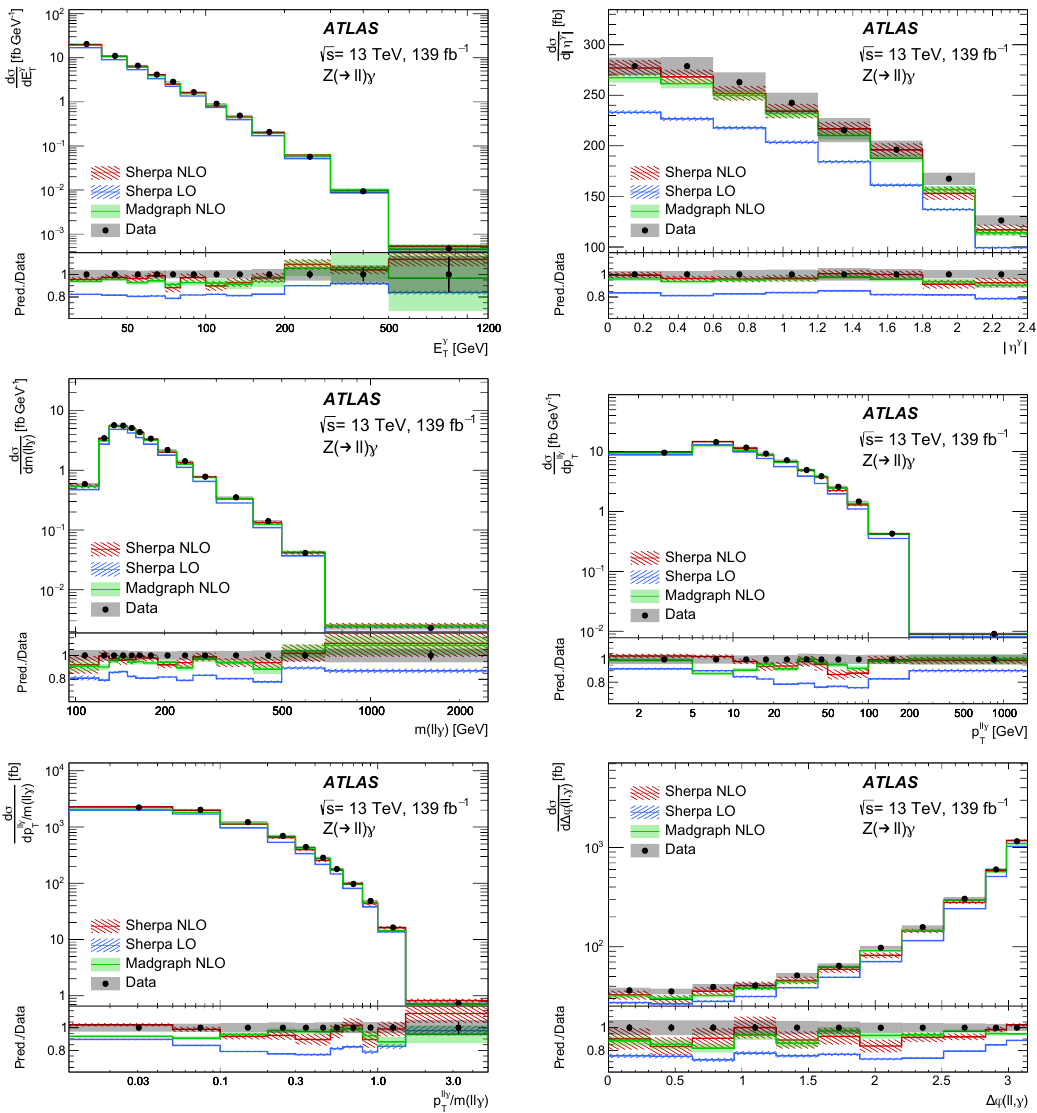
Figure 6 . Measured (cid:12)ducial cross-sections (black data points) for the observables (from left to right and top to bottom) E (cid:13) , j (cid:17) (cid:13) j , m ( ‘‘(cid:13) ), p ‘‘(cid:13) , p ‘‘(cid:13) =m ( ‘‘(cid:13) ) and (cid:1) (cid:30) ( ‘‘; (cid:13) ) for the pp ! Z ( ‘ + ‘ (cid:0) ) (cid:13) T T T process. The error bars on the data points show the statistical uncertainty in the measured values. The grey shaded regions show the total uncertainty in the unfolded data, excluding the uncertainty in the integrated luminosity. The measured cross-sections are compared with SM expectations obtained from the Sherpa and MadGraph5 aMC@NLO event generators at particle level. The uncertainty bands on the MC predictions show the statistical uncertainty due to the limited number of MC events. The lower section of each plot shows the ratio of the SM expectation to the measured cross-section.